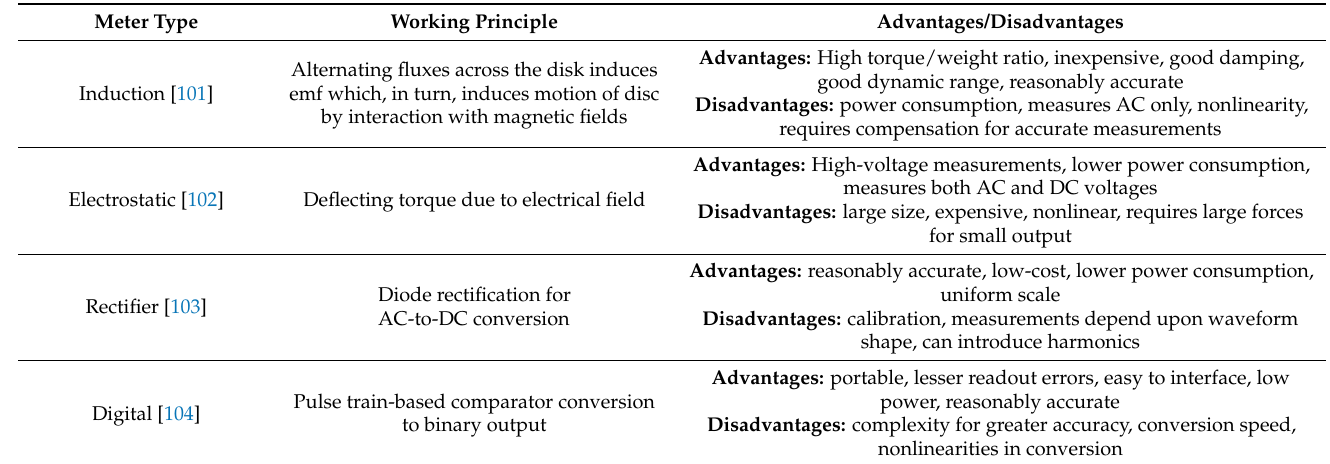
Table 4. Different types of voltmeters and their working